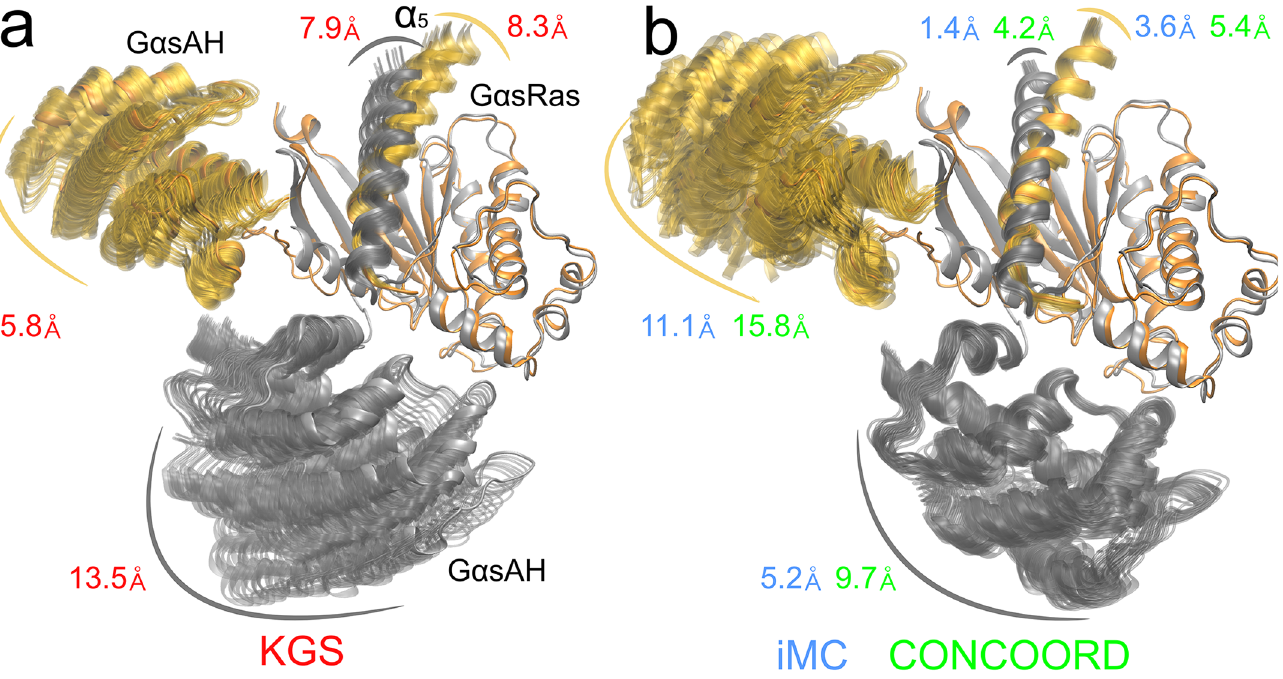
Fig 4. Comparison of the KGS, iMC and CONCOORD active and inactive Gs ensembles. a) Conformational ensembles of free, apo G α s protein obtained from KGS sampling starting from the active (orange) and inactive (gray) states. Spread of sampling over 20,000 samples is shown for the G α s AH- domain and the α 5 -helix of the G α s Ras-domain. b) The same as a), but for iMC and CONCOORD sampling. For visualization, we superimposed the G α s Ras-domains within the